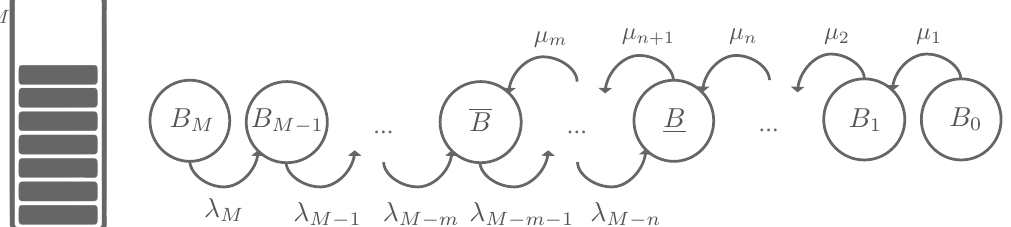
Figure 3. IoT device’s battery level as a Birth-Death process.